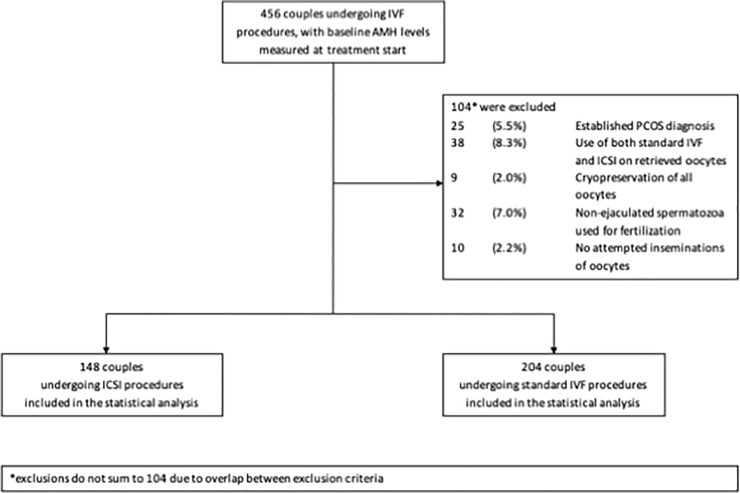
Flowchart for inclusion/exclusion of study participants.